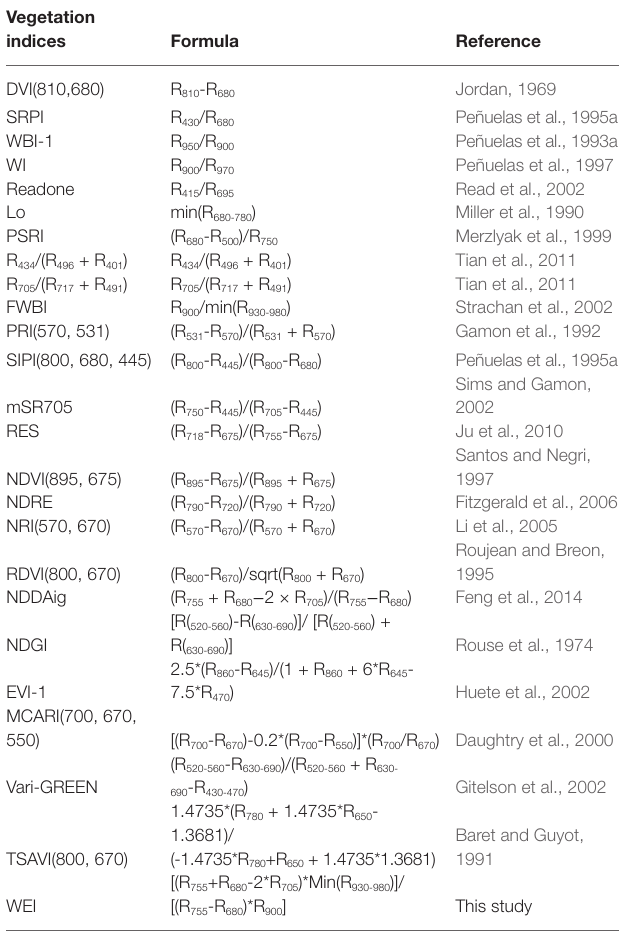
TABLE 2 | Summary of selected spectral parameters reported in the